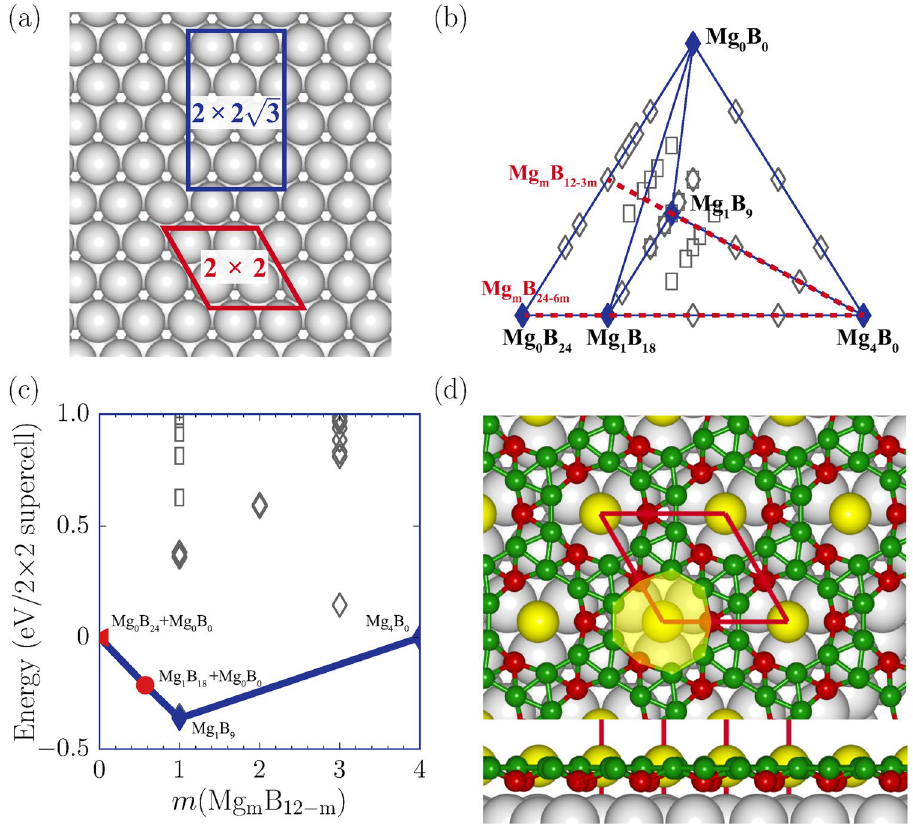
Figure 1. Phase diagram of Mg-B systems on Ag(111). ( a ) Rhombic 2 × 2 and rectangular × 2 2 3 supercells on the Ag(111) surface. ( b ) A phase diagram of 2D Mg-B systems on the substrate. In the 2 × 2 (rhombuses) and × 2 2 3 (rectangles) supercells, filled and open symbols stand for the stable and metastable states, respectively, and red dashed lines represent the B monolayer and bilayer coverages. ( c ) The convex hull diagram and ( d ) the lowest energy structure of Mg 1 B 9 for the monolayer coverage are drawn. Yellow, green, and gray balls represent the Mg, B, and Ag atoms, respectively, and red balls denote the B atoms sharing large triangles in the Kagome